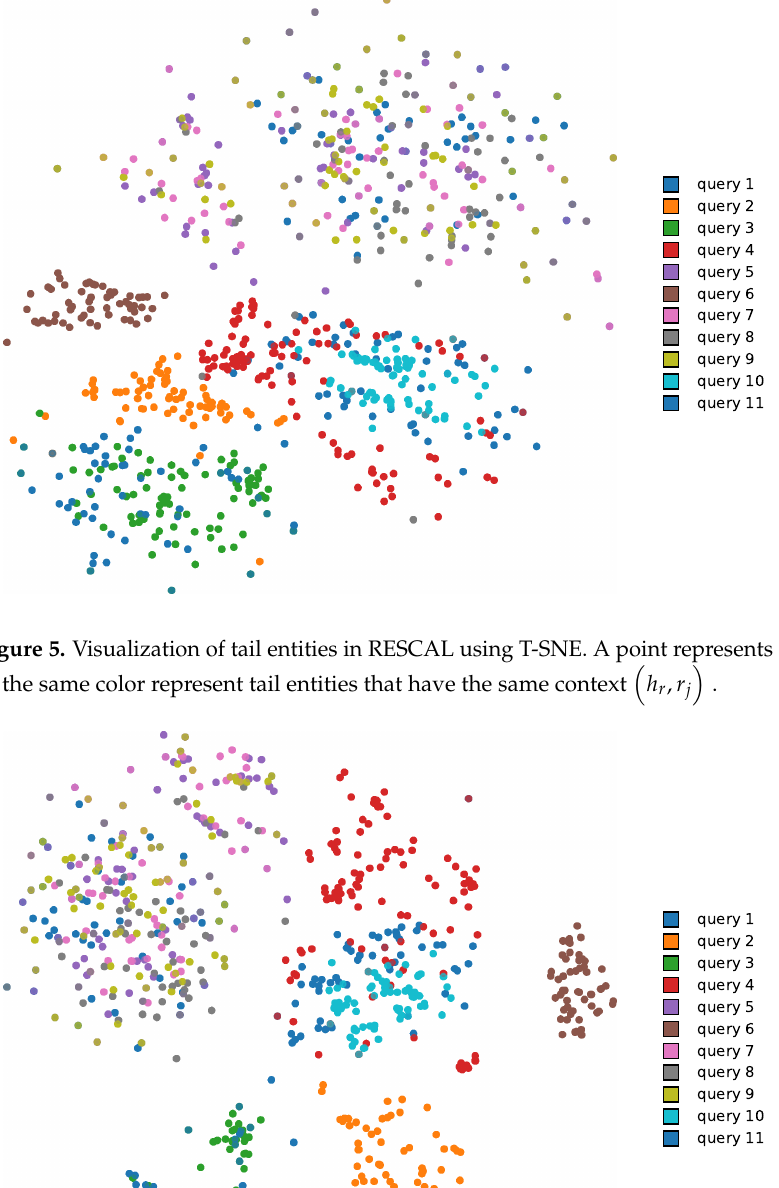
Figure 6. Visualization of tail entities in SeAttE using